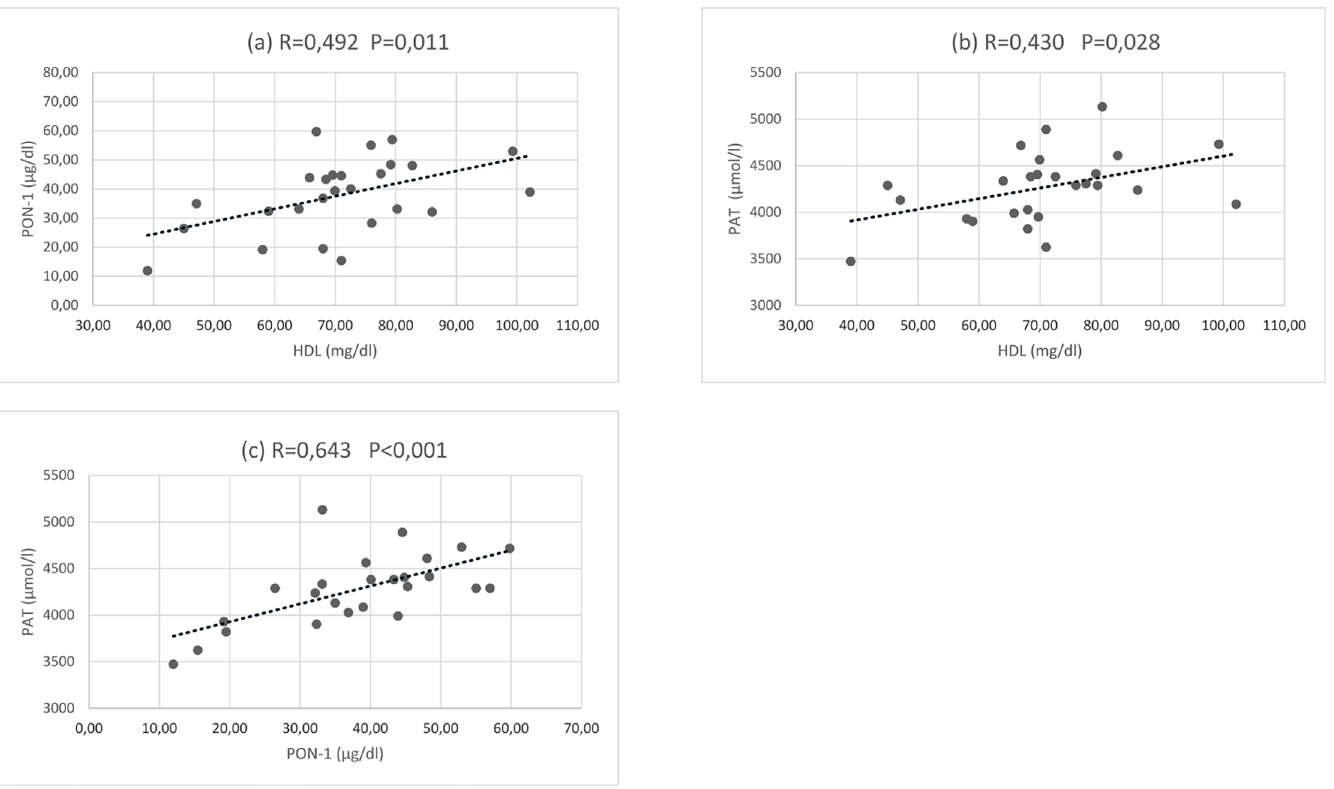
Fig 1. Linear correlations between HDL and PON1 (a), HDL and PAT (b), and PON1 and PAT (c).